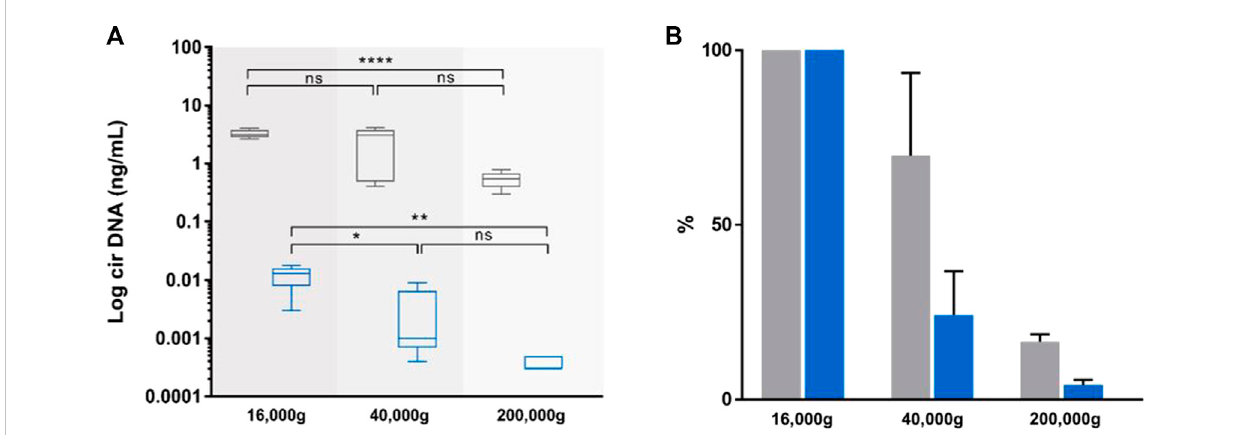
FIGURE 4 Effect of incremental centrifugation speed on plasma from fi ve healthy individuals. Comparison of the concentrations [ (A) , ng/mL], and variations [ (B) , %)] of circulating nuclear DNA (cir-nDNA, grey) and circulating mitochondrial DNA (cir-mtDNA, blue) in plasma as prepared by the protocol without plateletactivation.cirDNAconcentrationwasdeterminedinthesupernatantfollowingthesubsequentcentrifugationstepsoftherespectivesupernatant at 16,000 g, 40,000 g and 200,000 g. ns, non-statistically signi fi cant; * p < 0.05, ** p < 0.01; **** p <